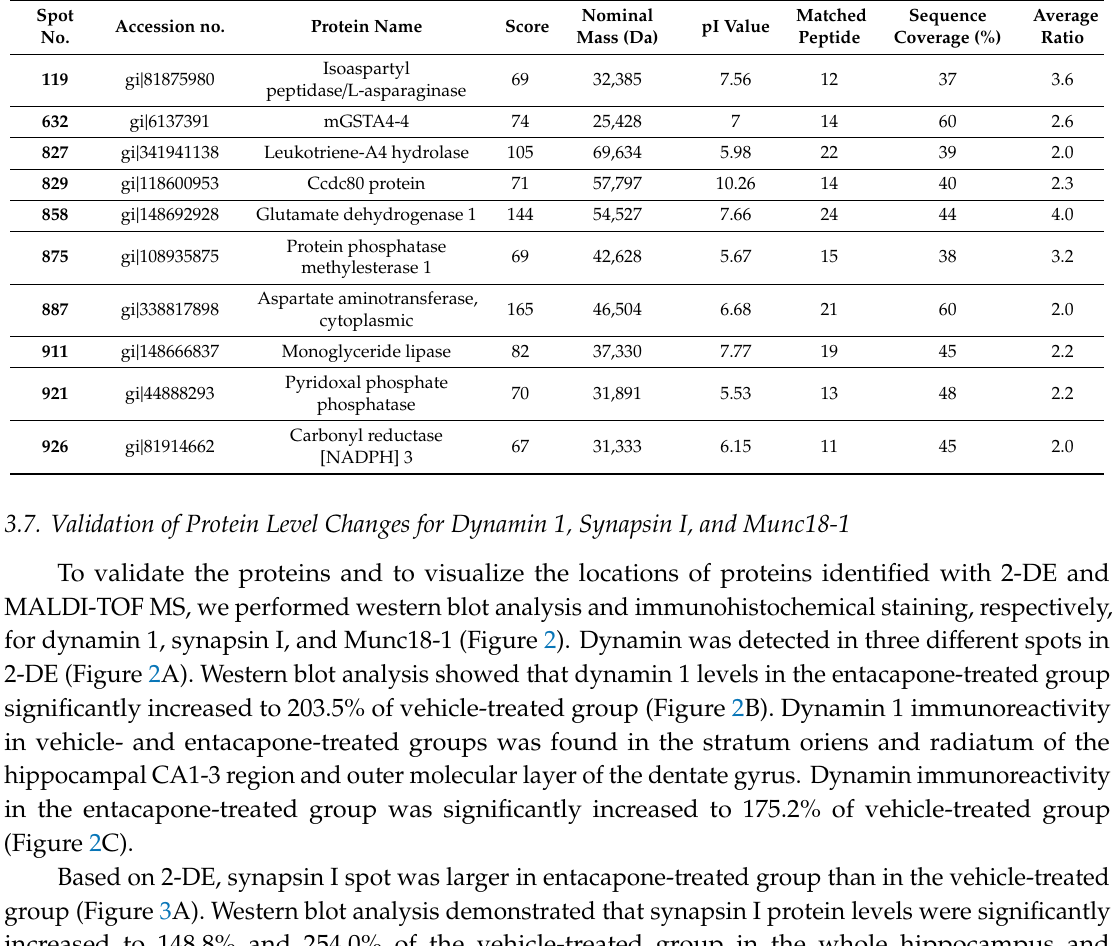
Table 5. Di ff erentially expressed proteins related to enzyme activity after entacapone treatment in the